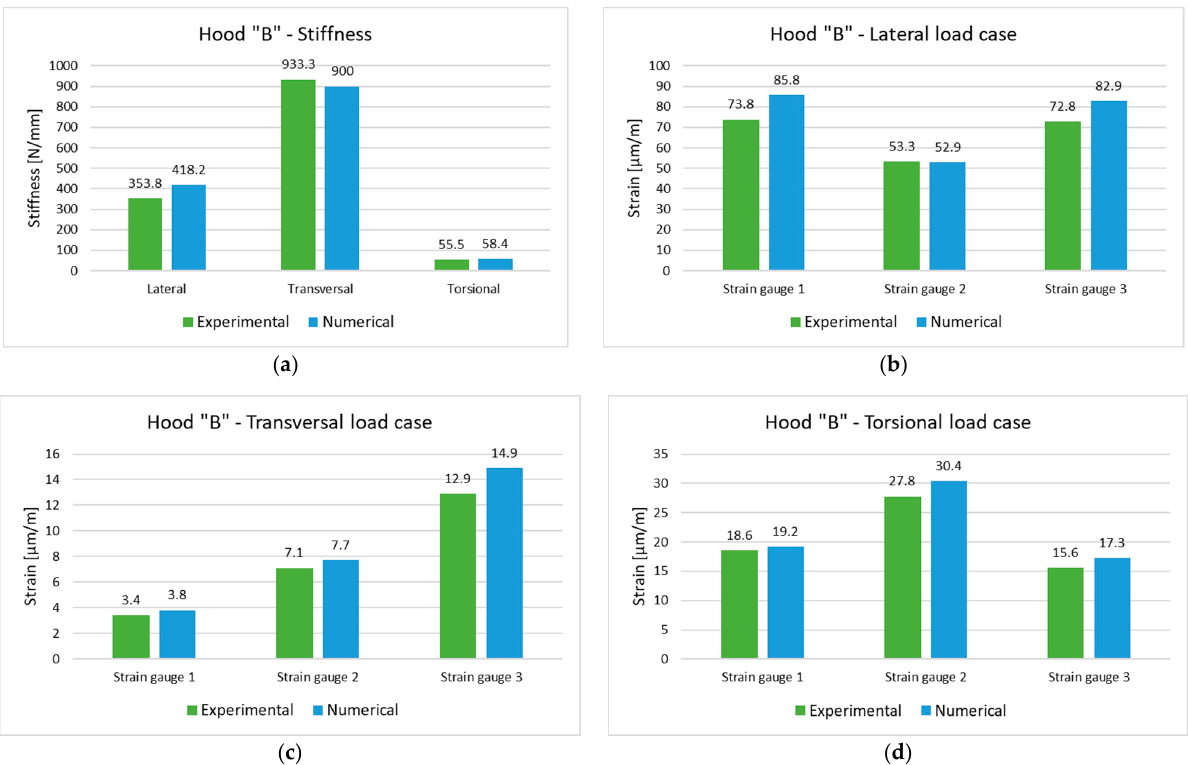
Figure 19. Comparative analysis of experimental and numerical (simulated) values for the composite hood “B”: ( a ) stiff- nesses; ( b ) strains in lateral load case; ( c ) strains in transversal load case; ( d ) strains in torsional load case.